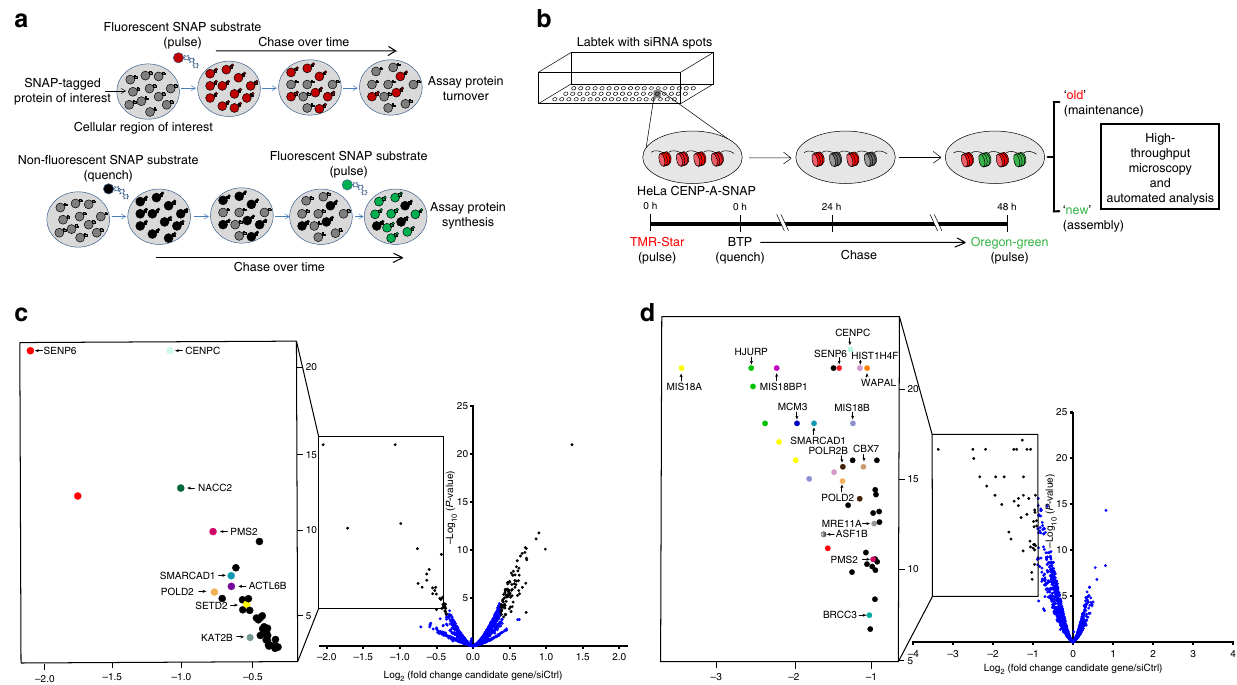
Fig. 1 An imaging-based screen identi fi es CENP-A maintenance and assembly factors. a Schematic depicting the SNAP tag-based labeling assay in order to track the maintenance and turnover (red) or de novo assembly (green) of a SNAP-tagged protein. b Flow scheme of high throughput siRNA screen designed to identify proteins controlling the loading or maintenance of CENP-A. HeLa CENP-A-SNAP cells, pulse labeled with TMR-Star were seeded onto chamber slides carrying 384 siRNA printed spots. During RNAi, cells were chased for 48 h followed by labeling of nascent CENP-A-SNAP with Oregon Green. CENP-A maintenance or assembly was assessed by high throughput fl uorescence microscopy of red (old) or green (new) CENP-A-SNAP signals, respectively. c Volcano plot representing the results of the siRNA screen scoring for defects in maintenance of pre-assembled CENP-A. The fold change of mean ‘ old ’ CENP-A intensity in the candidate siRNA treatment vs. that of a negative scrambled siRNA control are plotted on the x -axis in log 2 scale. The p - values of the candidate siRNA treatment as a measure of reproducibility across 5 biological replicates of the screen are plotted on the y -axis in negative log 10 scale. The top candidate maintenance factors with a cut-off lower than a fold change (log 2 ) of − 0.4 and higher than a p -value ( − log 10 ) threshold of 3 are boxed and highlighted (identically colored dots represent different siRNA targets for the same gene). d Volcano plot as in c representing the results of the siRNA screen scoring for defects in CENP-A assembly. The top candidate assembly factors with a cut-off lower than a fold change (log 2 ) of − 0.9 and higher than a p -value ( − log 10 ) threshold of 5 are boxed and